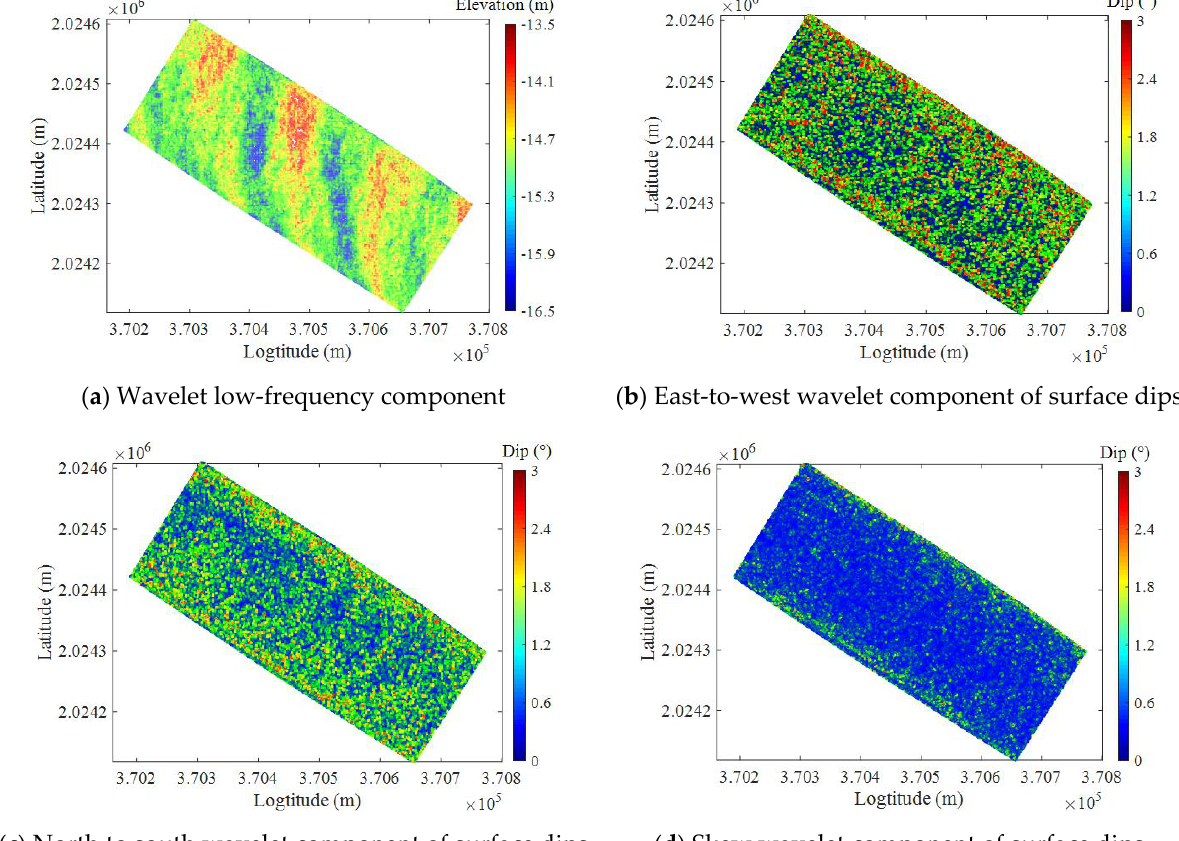
Figure 3. Multiscale decomposition (1-layer) of surface elevations and dips. Wavelet soft threshold denoising is mainly carried out for the high-frequency components, and the filtered result can be restored to the water surface point cloud through the inverse wavelet transform.